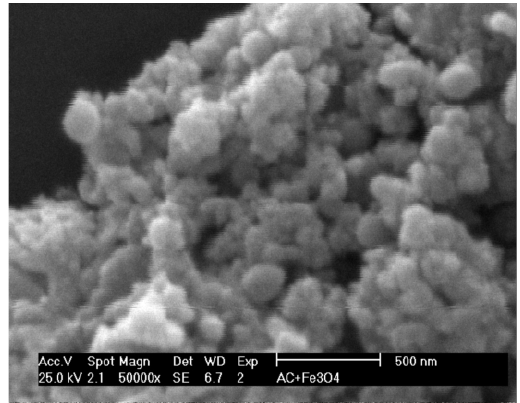
Fig. 2. SEM image of